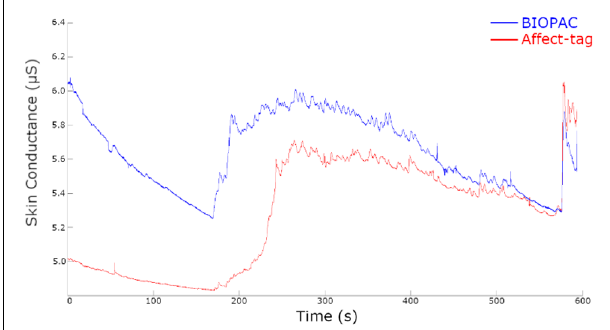
FIGURE 1 | Raw EDA signals for a single participant simultaneously measured using BIOPAC and